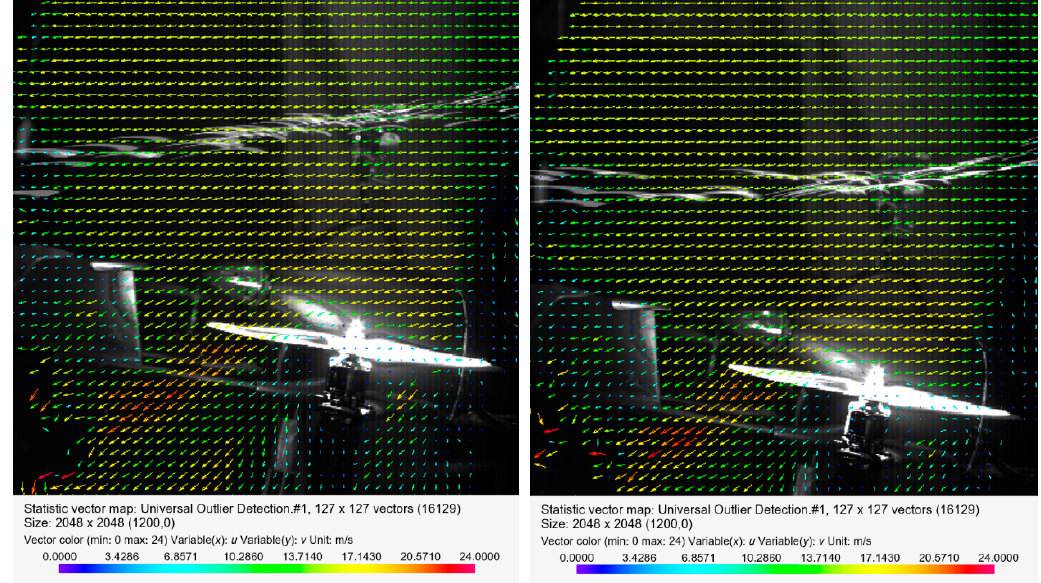
Figure 15. Velocity field around the horizontal propellers for the following configuration: angle of attack α = − 12° (on the left) and angle of attack α = − 13.5° (on the right), with an airflow velocity of v wt = 12.5 m/s.